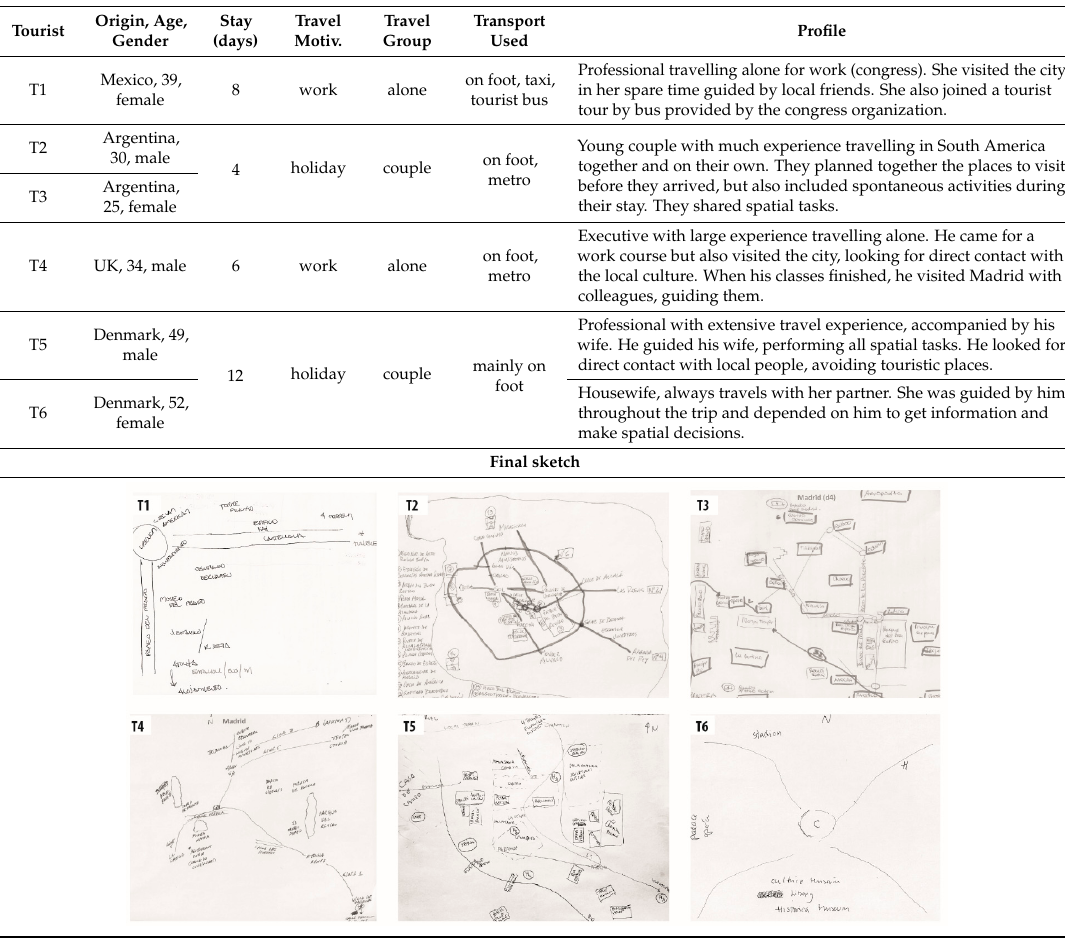
Table 1. Individual and contextual factors, profile, and final sketch of tourists who wrote diaries.